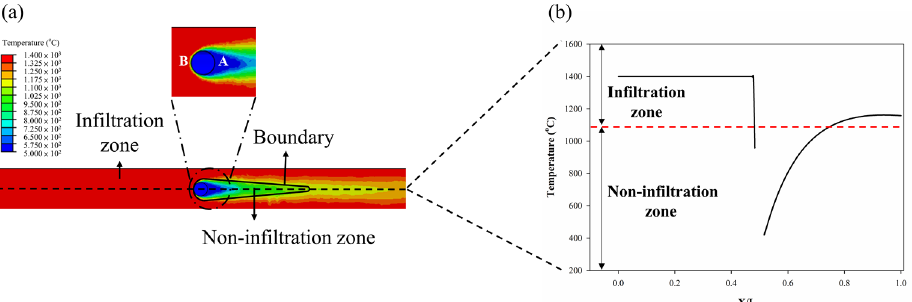
Figure 5. ( a ) Outlined photo for illustrating the infiltration zone and the overall temperature distri- bution and ( b ) the temperature distribution along the dashed line at the initial stage.